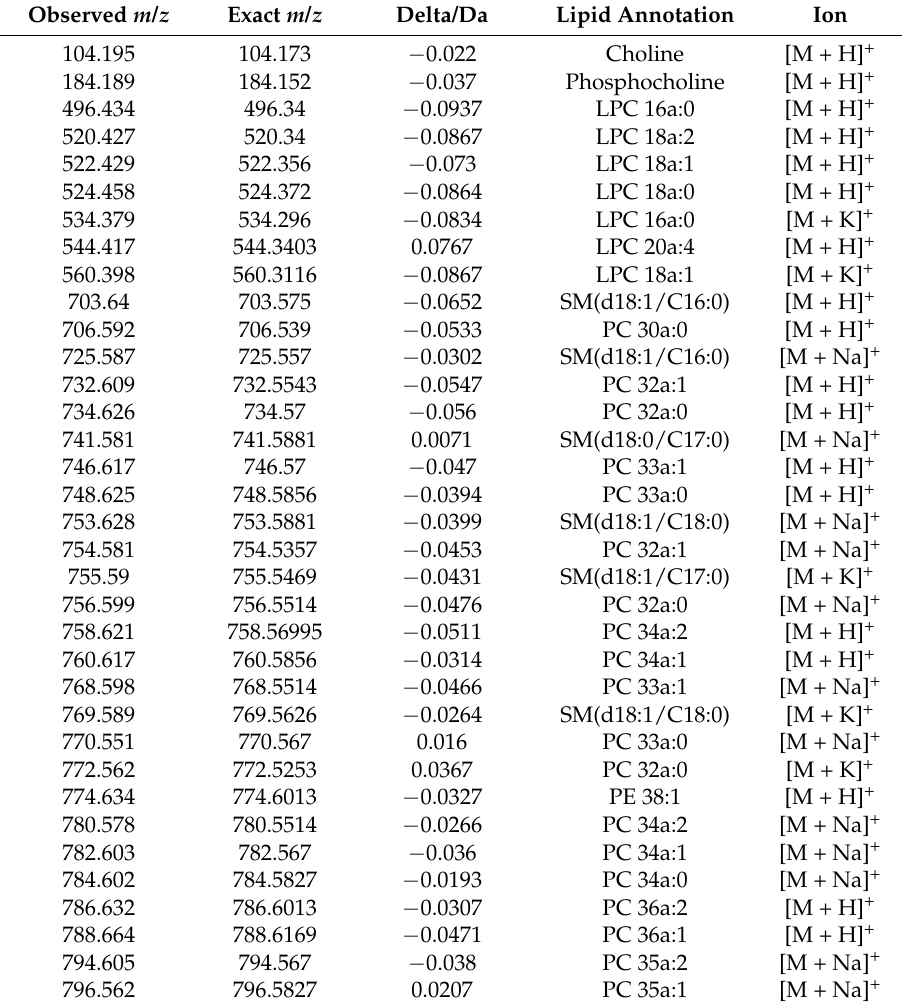
Table A1. Identification of the lipids detected by mass spectrometry imaging (Figure